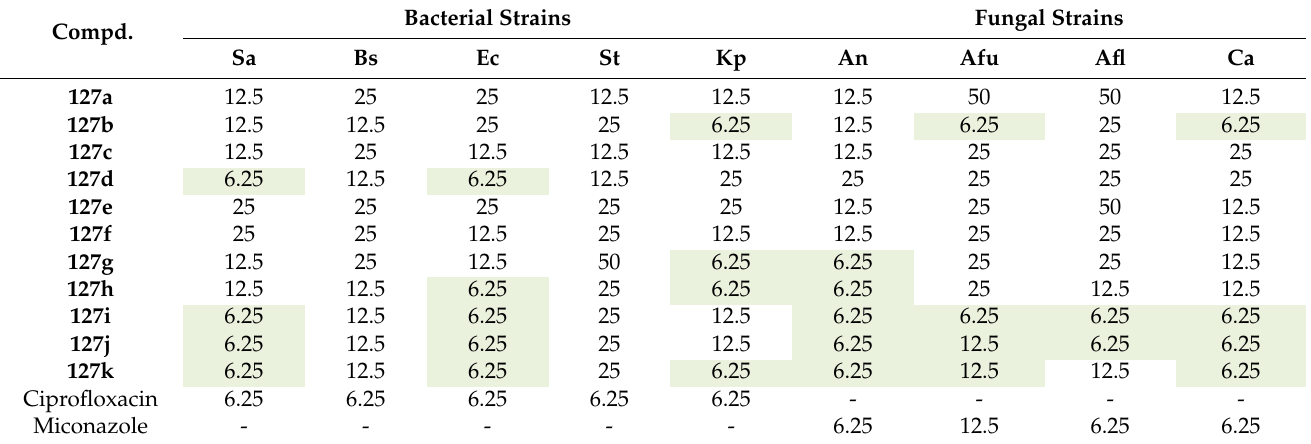
Figure 13. Structures of compounds 128 − 132 [58]. Table 6. Antimicrobial activity (MIC values in µg mL − 1 ) of pyridine triazoles 122a − 122k [57]. Compd.